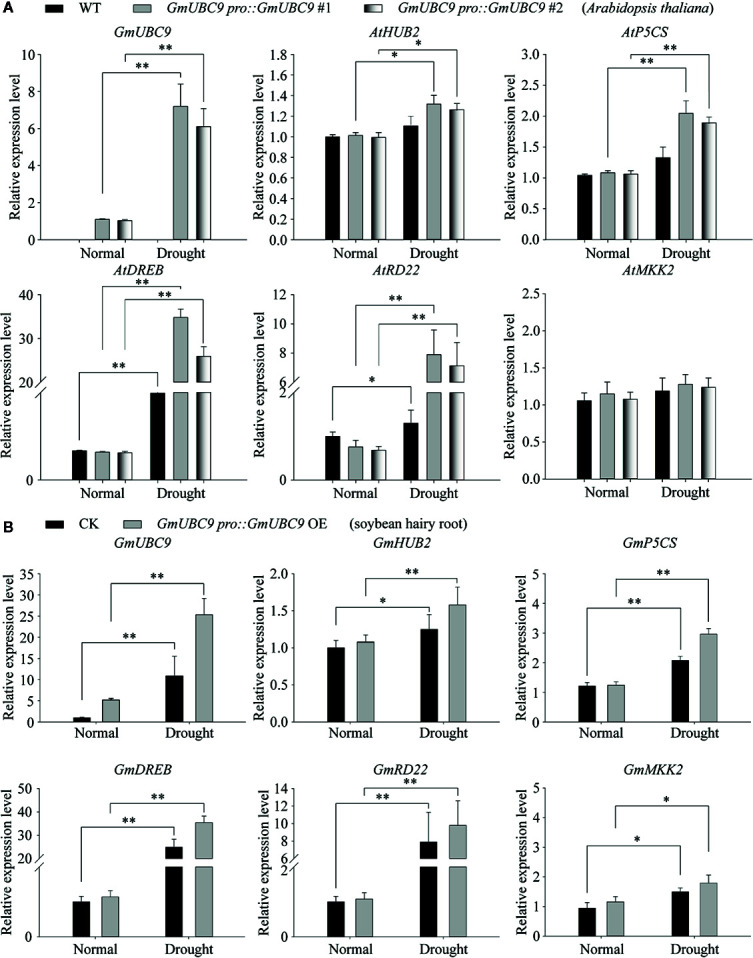
Overexpression of GmUBC9 significantly increased the expression level of drought resistance genes in Arabidopsis and soybean hairy root lines under drought conditions. RT-qPCR assessment of stress-responsive gene expression in control, GmUBC9-overexpression Arabidopsis lines (A) and GmUBC9-overexpression soybean hairy root lines (B). The RNA extracted from the roots of the indicated genotypes (4 weeks old) prior to or following drought treatment for 4 days. Data are normalized to GmCYP2 expression levels. The analysis was performed with 3 independent biological replicates. Vertical bars represent the SD. (*P < 0.05; **P < 0.01; Student’s t-test).